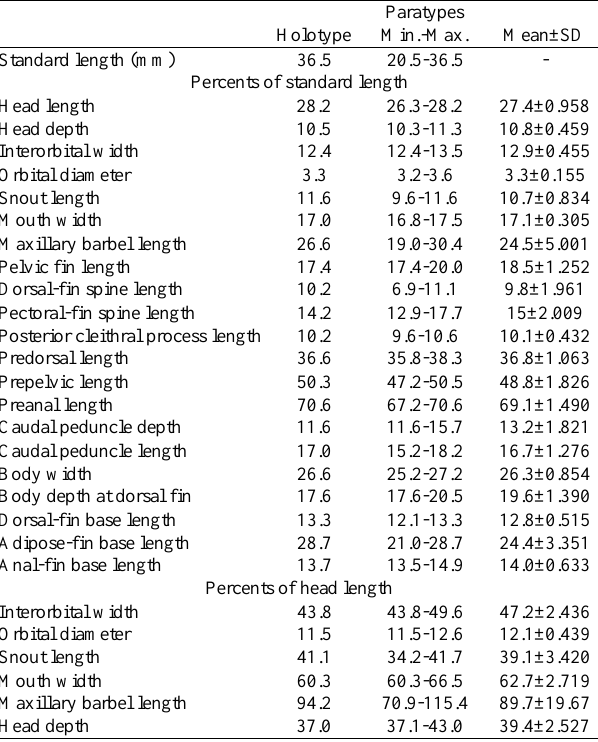
Table 1. Morphometric data of Microglanis maculatus (n = 4). SD = standard deviation.